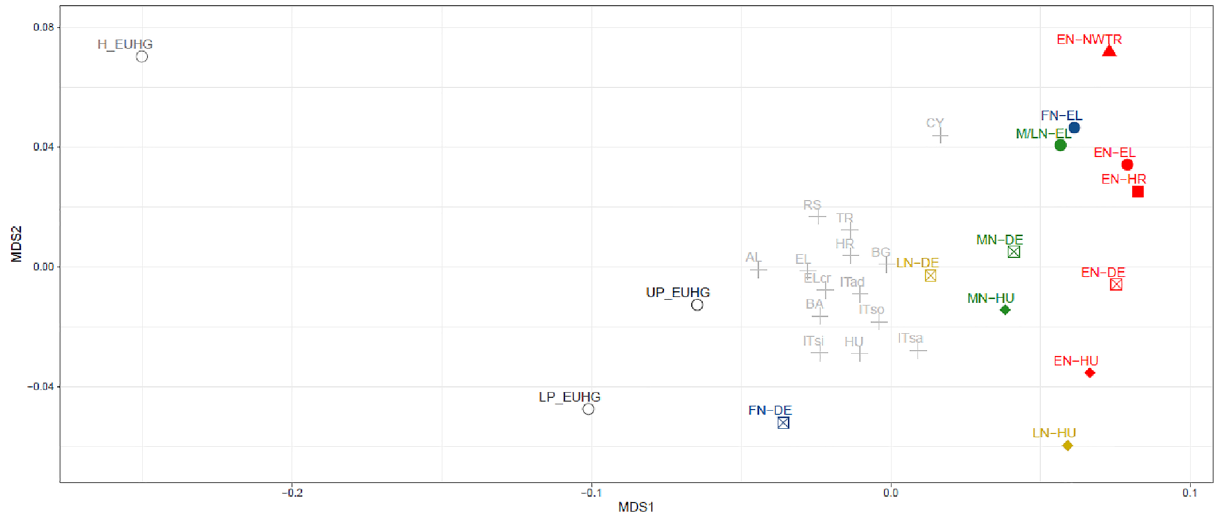
Figure 3. MDS with the 47 Greek Neolithic samples (42 newly sequenced and 5 published, EL, plain circles) and a reference panel of 26 ancient and present-day populations (2470 individuals in total), stress = 0.099 (EN: Early Neolithic, MN: Middle Neolithic, LN: Late Neolithic, FN: Final Neolithic, EUHG: hunter-gatherers, H_EUHG: Holocene EUHG, UP_EUHG: Upper Palaeolithic EUHG, LP_EUHG: Lower Palaeolithic EUHG, NWTR: north western Turkey, EL: Greece, DE: Germany, HR: Croatia, HU: Hungary, grey stars = modern populations abbreviations can be found on Table S3).